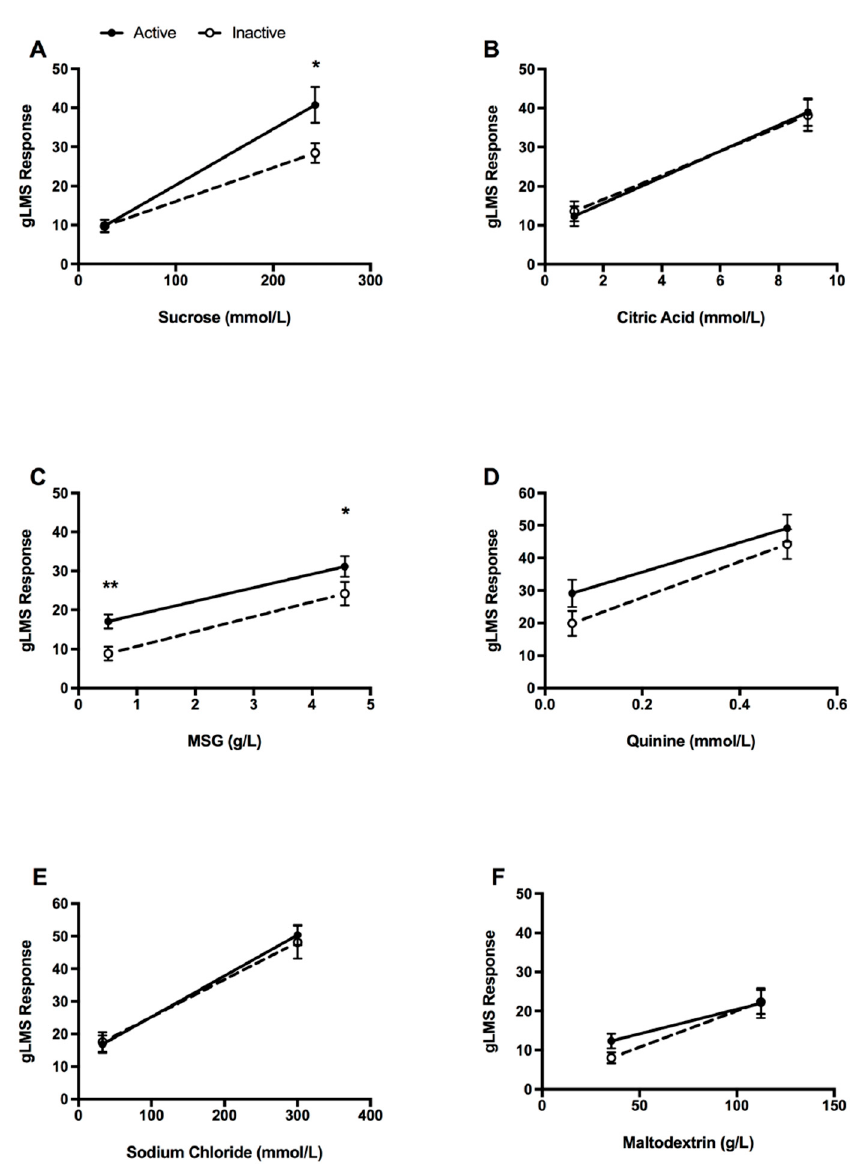
Figure 1. Differences (mean (SE)) in perceived intensity responses on a generalised labelled magnitude scale (gLMS) for high and low concentrations of: ( A ) Sweet, ( B ) sour, ( C ) umami, ( D ) bitter, ( E ) salt, and ( F ) carbohydrate (maltodextrin) taste intensity ratings with physical activity. Solid dark line indicates active group, dashed line indicates inactive group. * p < 0.05, ** p < 0.01. MSG, monosodium glutamate.